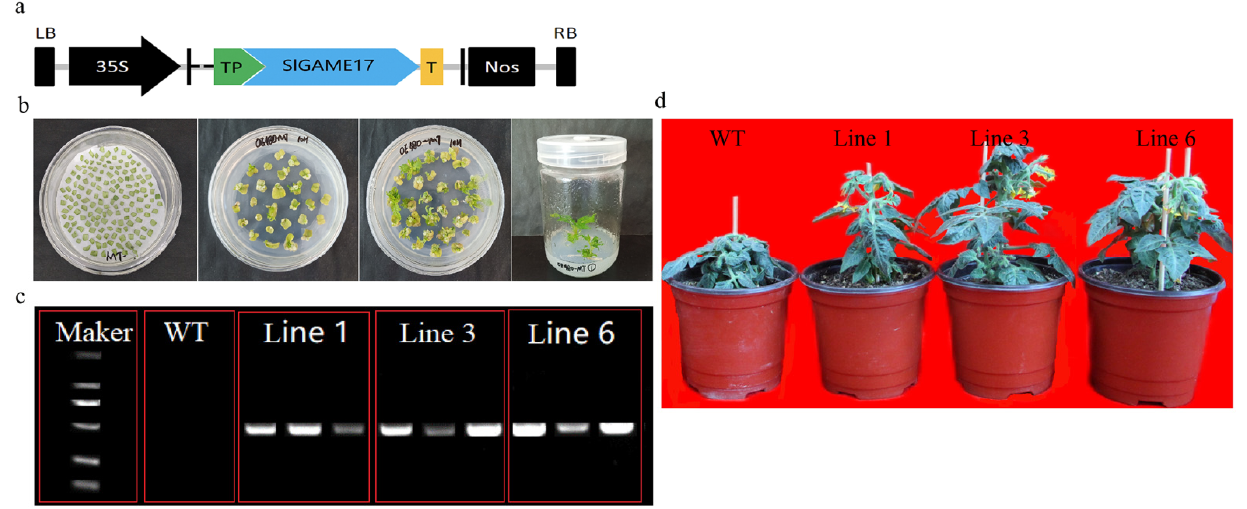
Figure 5. Generation and identification of transgenic tomato plants. ( a ) Schematic diagram of vec- tors for tomato transformation. ( b ) The construction of tomato transformation. ( c ) Characterization of transgenic tomato lines. Maker: DL2000 DNA marker. WT: the wild-type tomato leaves. Line 1, 3 and 6 represent three representative transgenic lines. ( d ) The phenotypic differences between WT and transgenic tomato plants.